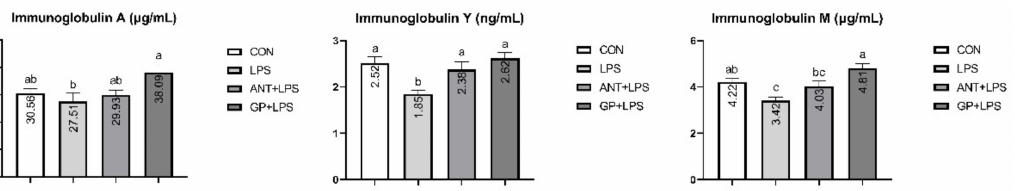
Figure 1. Effects of dietary garlic powder inclusion on serum immunoglobulins levels in broilers challenged with lipopolysaccharide (data were presented as mean and SEM, means that do not share the same superscript are significantly different, p < 0.05).